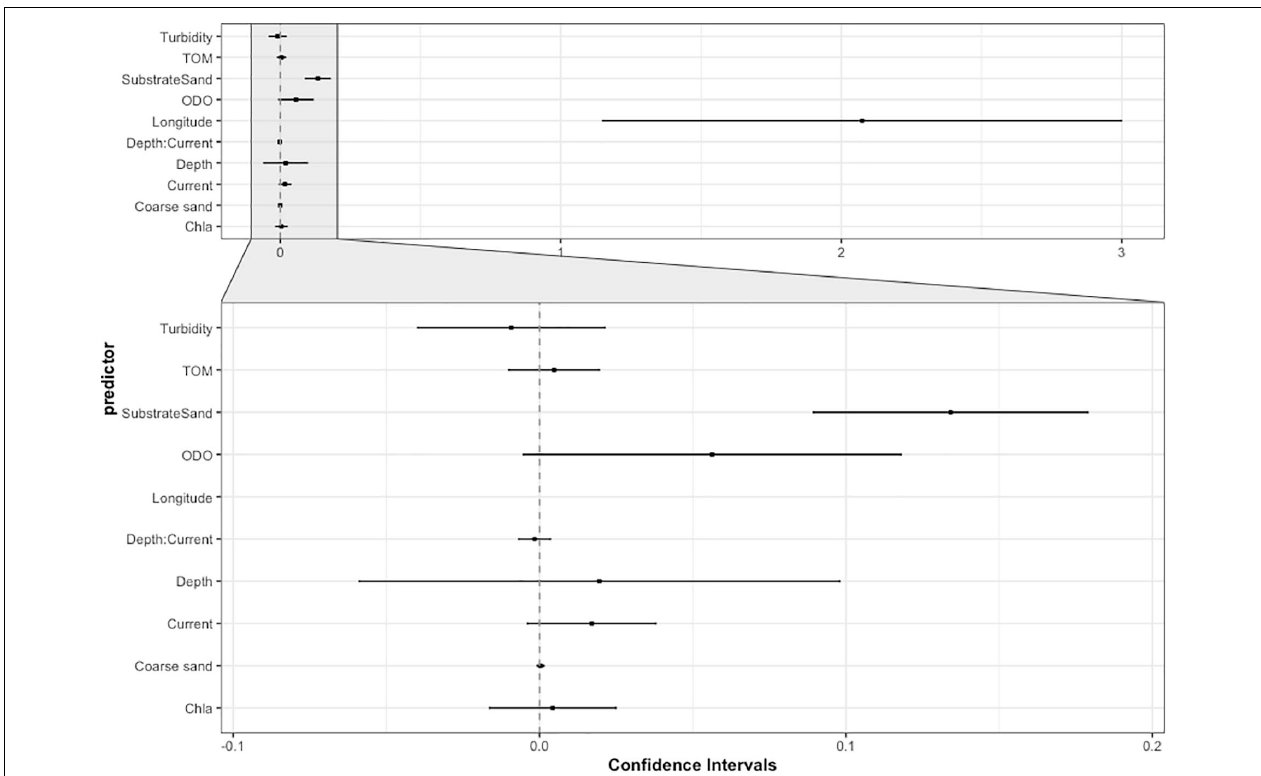
FIGURE 9 | Confidence intervals for the predictor coefficients of the model – Fixed-effect GLM averaged model with a Gamma distribution – explaining the size distribution patterns of Holothuria mammata at Arrábida, Setúbal.